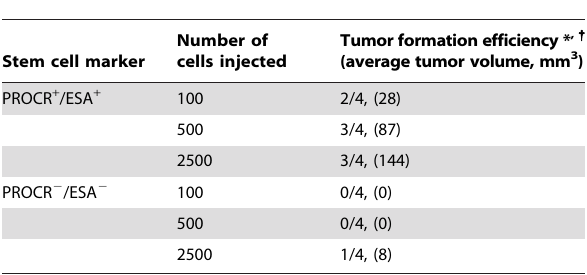
Table 2. Xenograph and tumor growth in NOD/SCID injected with PROCR + /ESA + or PROCR 2 /ESA 2 MDA-MB-231 cells.